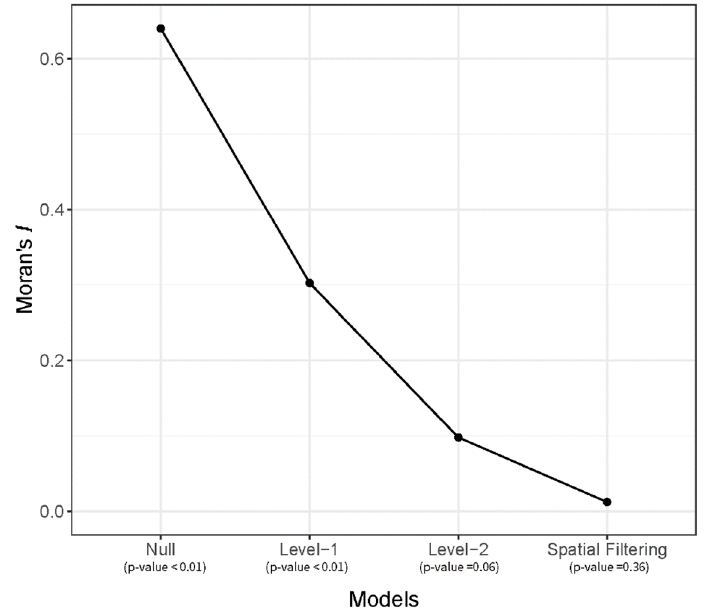
Figure 4. Spatial autocorrelation in random effects of multilevel models.